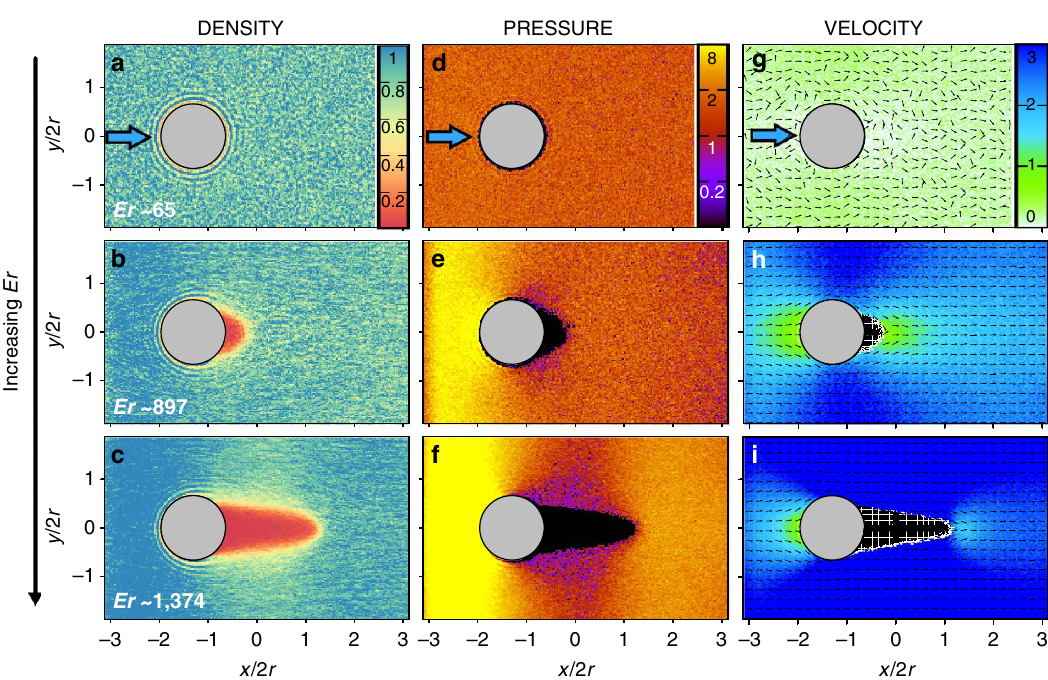
Figure 3 | MD simulation of the hydrodynamic states. ( a – c ) Maps of the magnitude of local density in the x–y plane located at z ¼ 0 (see attached color bar). The circle represents the cylindrical pillar and the arrow above each column indicates the direction of flow, at different Ericksen numbers: ( a ) Er C 65, ( b ) Er C 897 and ( c ) Er C 1,374. ( d – f ) MD simulated local pressure plots and ( g – i ) corresponding local velocity fields, carried out at the same Er as in ( a – c ). Colour bars attached to plots in the top panel refer to all plots in the same